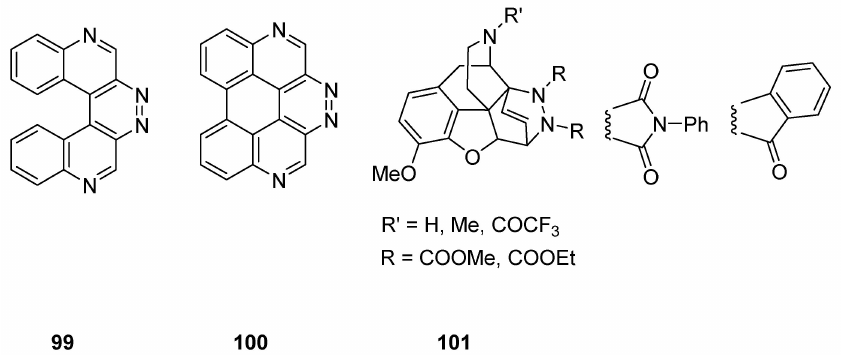
Figure 4. Different polycyclic pyridopyridazine